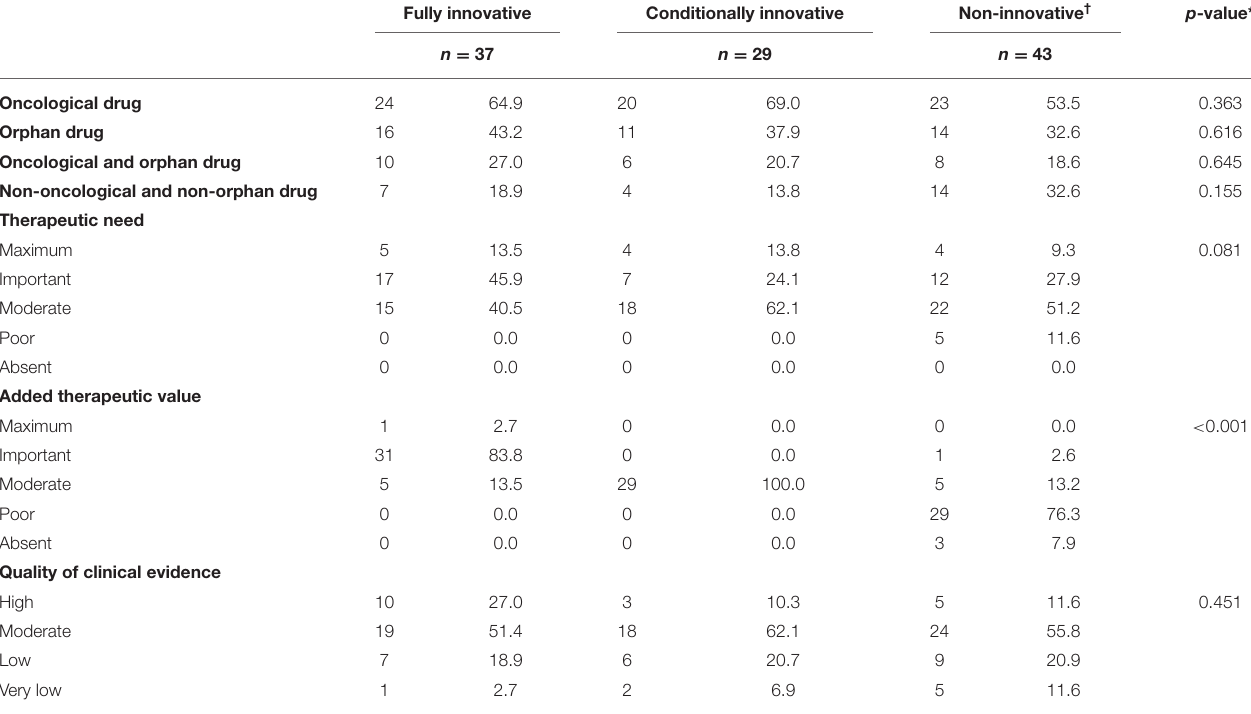
TABLE 1 | Characteristics of drugs criteria considering the drug’s degree of innovation.